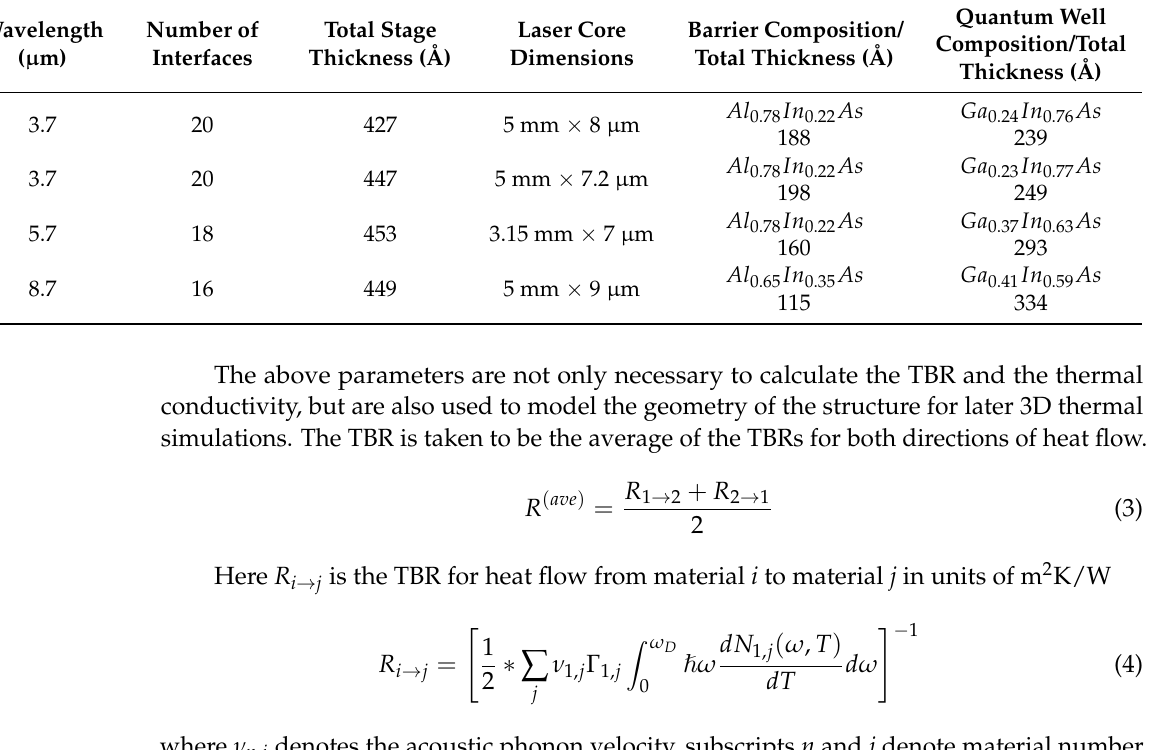
Table 1. Material parameters of samples in this